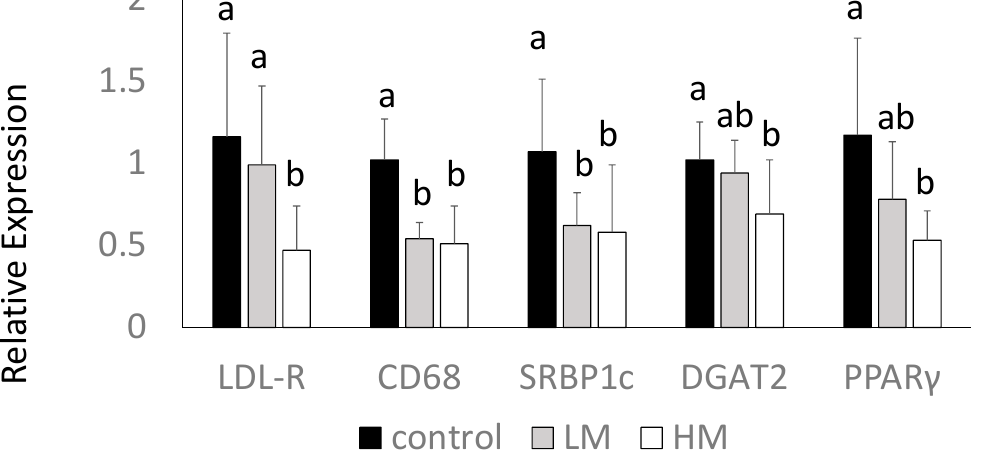
Figure 3. Hepatic gene expression of LDL receptor ( LDL-R ), cluster of differentiation 68 ( CD68 ), SREBP1 , DGAT2 and PPAR γ of guinea pigs fed control ( black bars), Low Moringa (LM; 10%, gray bars) or High Moringa (HM; 15%, white bars). Different superscripts, a and b denote significantly different at p < 0.05.